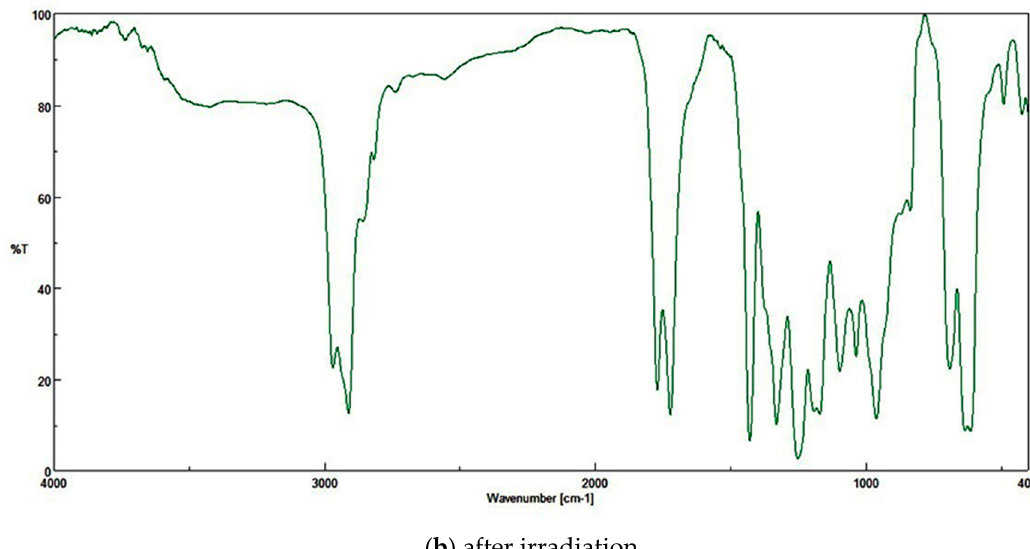
( b ) after irradiation Figure 2. The FTIR spectra for PVC films (30- μ m thickness) with Schiff’s base 1 (0.5% by weight) as additive before ( a ) and after ( b ) irradiation.